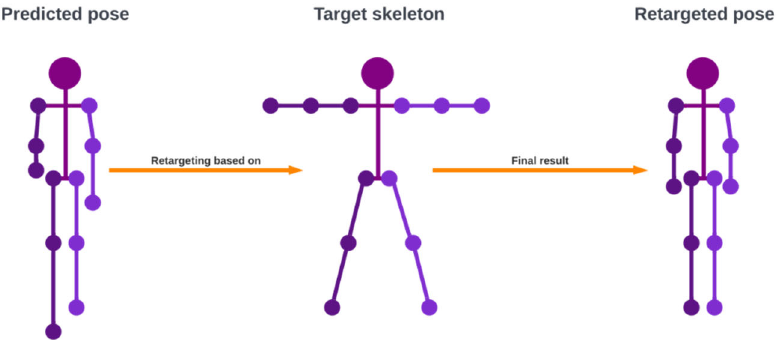
Figure 7. An example of pose retargeting where the predicted pose is retargeted based on the target skeleton. Retargeting will translate the joint angles from the predicted pose to a standardized skeleton, thus ensuring that a pose has the same lengths of limbs.